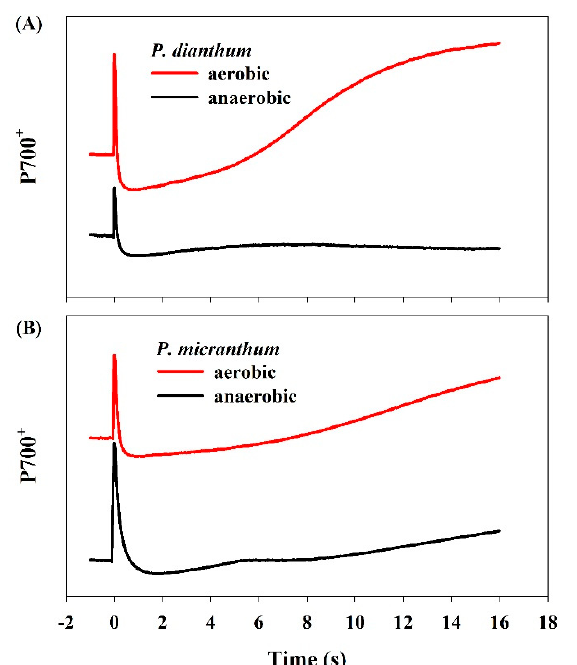
Figure 5. The redox changes of P700 upon dark-to-light transition in Paphiopedilum dianthum ( A ) and P. micranthum ( B ) under aerobic and anaerobic conditions. Each line represents the mean for five measurements from five individual plants. The red line and the black line are the measured values of P700 + under aerobic and anaerobic conditions, respectively.